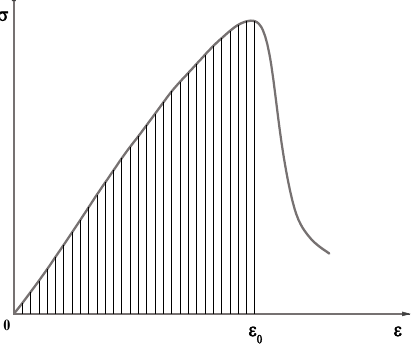
Figure 2. Stress-strain curve of beam bending test of the asphalt mixture.